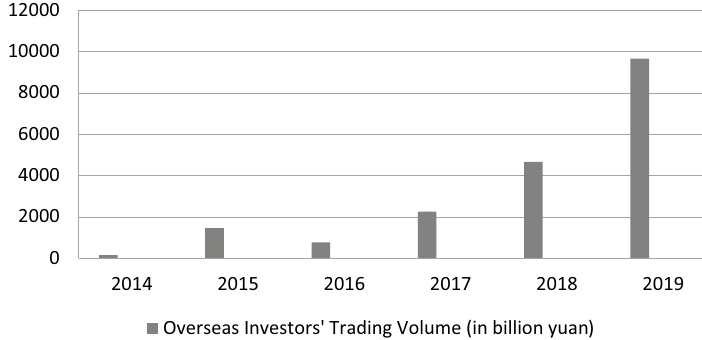
Fig. 1 Overseas investors’ trading volume (in billion